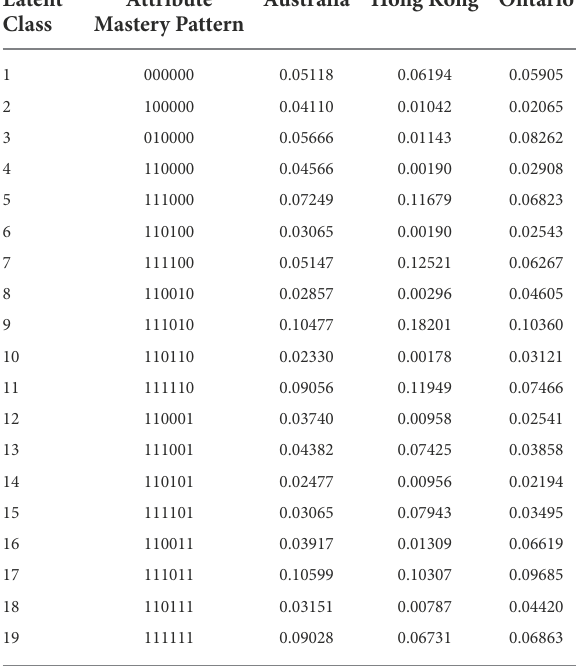
Table 3 Latent class